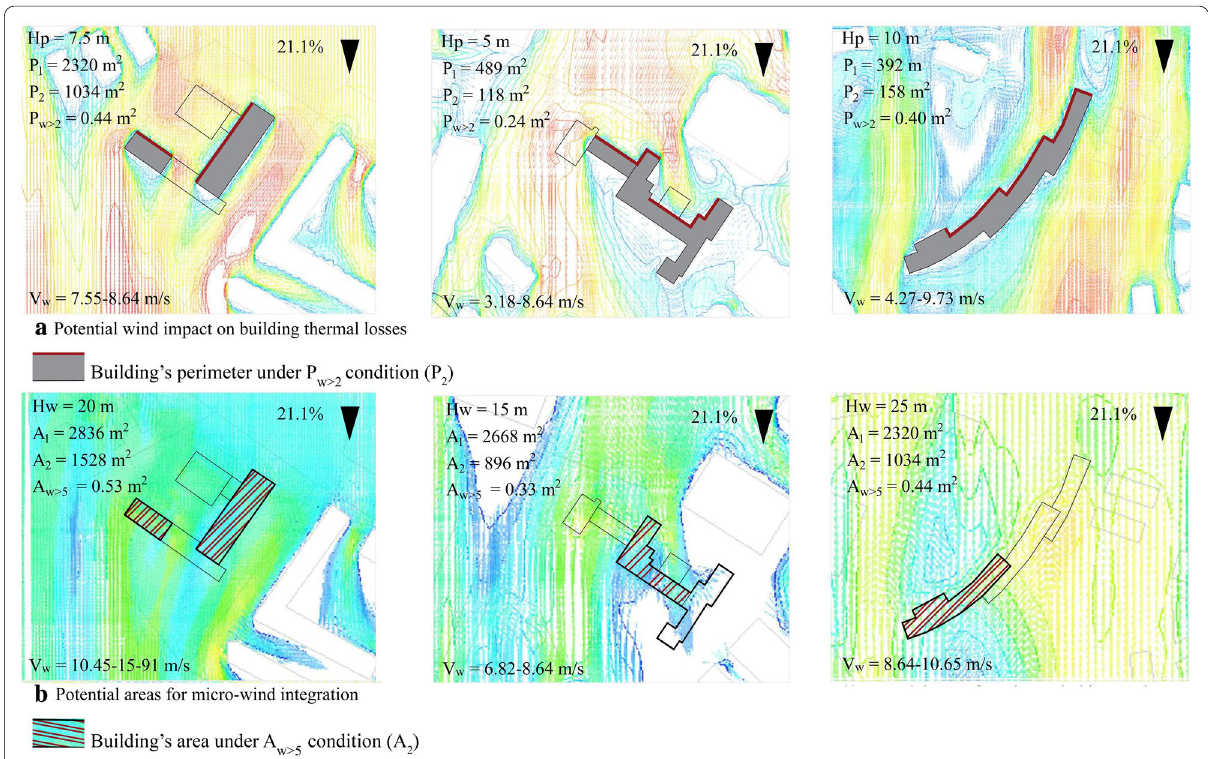
Fig. 5 Wind thermal-loss index (P w>2 ) and wind energy production (A w>5 )